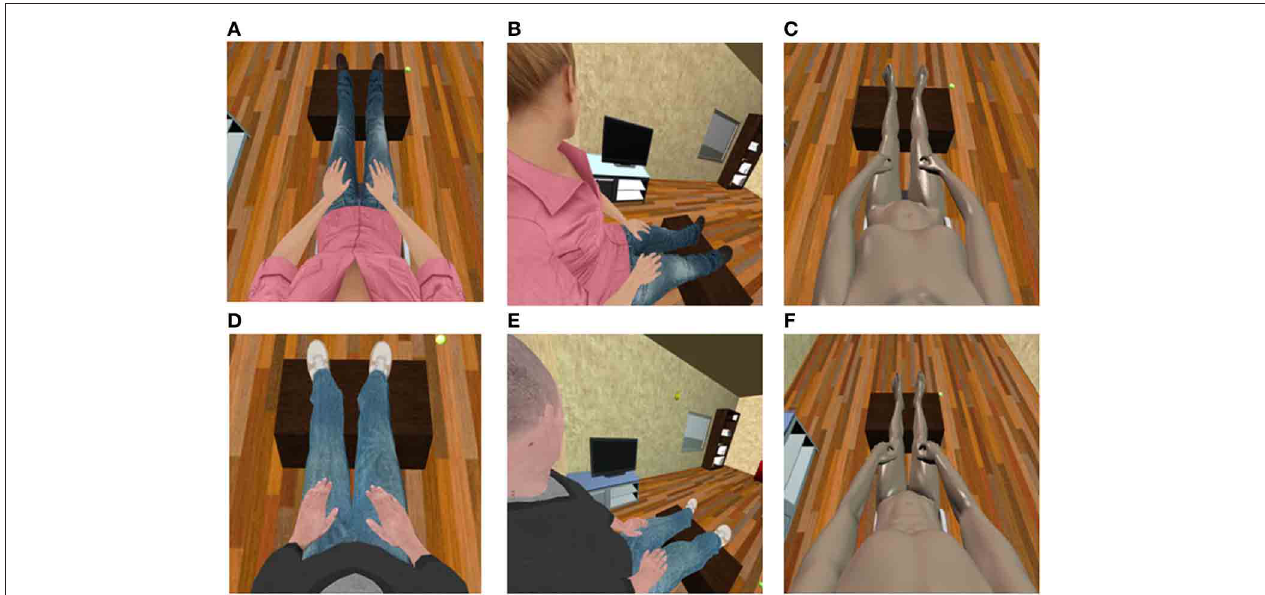
participants saw a virtual body in their near extrapersonal space when looking to the left. The two levels of the factor “bodily appearance” are shown in [A,C (D,F)] for a female (male) participant: in the HA conditions participants had a co-located virtual body with a realistic human appearance (A,D) , while in the MA condition a co-located virtual body resembling a plastic mannequin (C,F)